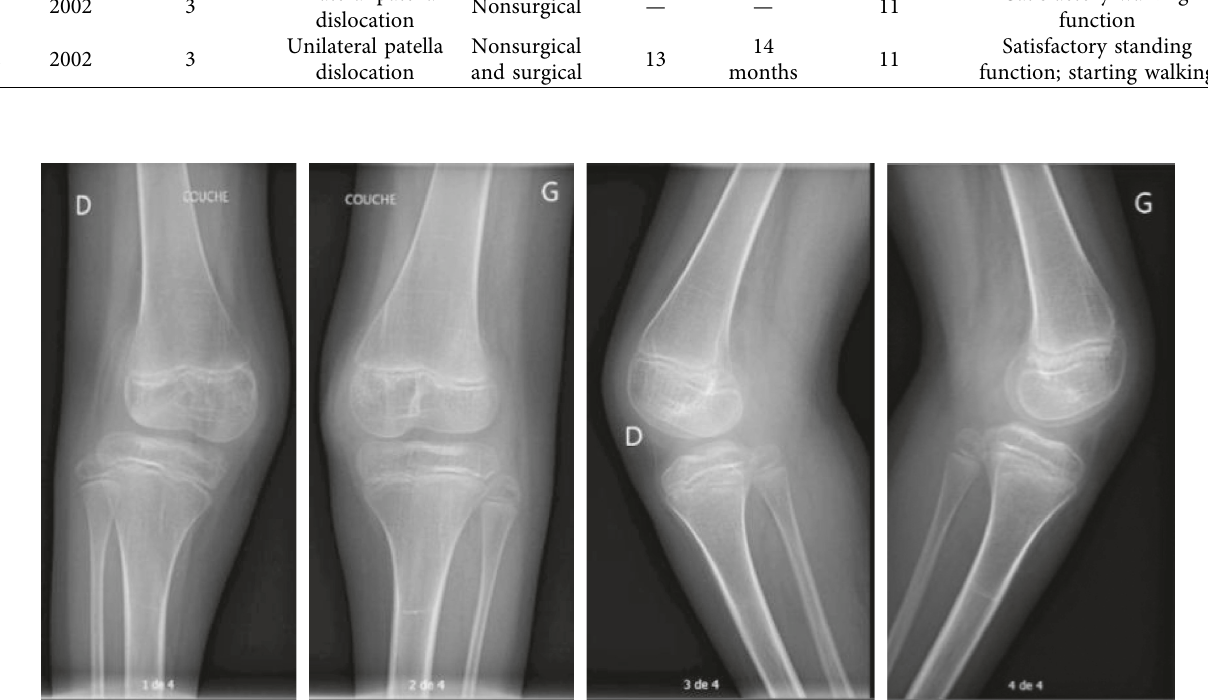
Figure 1: Patient 1: knee X-rays at follow-up (age